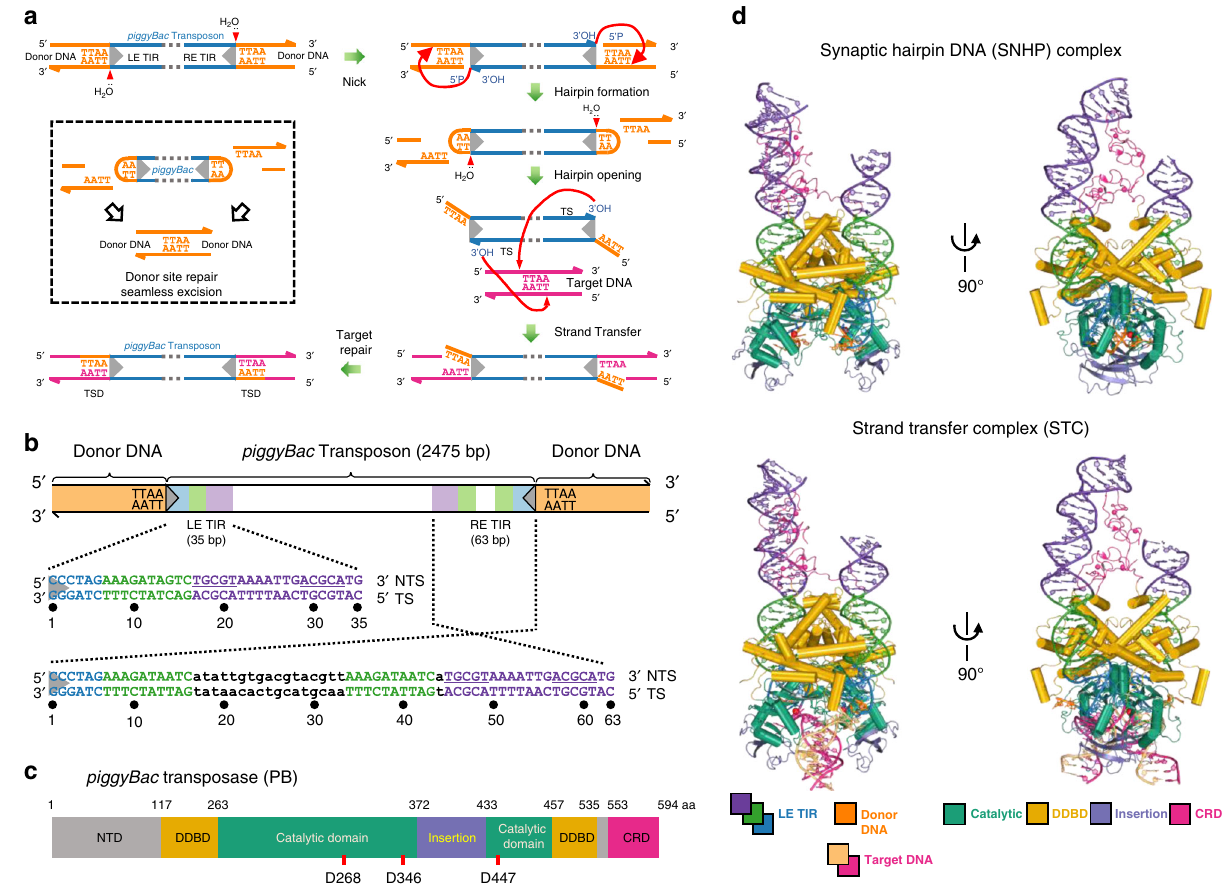
Fig. 1 Overview of piggyBac transposition. a Mechanism of piggyBac ( pB ) transposition. Hydrolysis by the piggyBac transposase (PB) liberates the 3 ′ -OH on the DNA strand that will be integrated. This is followed by transesteri fi cation in which this 3 ′ -OH attacks fl anking DNA four nt from the transposon end forming a DNA hairpin. For subsequent integration, PB opens the hairpin at each end in another hydrolytic step, leaving a four nt TTAA overhang; this is followed by a second transesteri fi cation step that joins each end to target DNA. At the empty donor site (inset), complementary DNA strands allow for seamless repair. LE left end, RE right end, TIR terminal inverted repeat, TSD target site duplication. b Schematic of pB transposon fl anked by TTAA, and sequence and organization of the LE and RE TIRs. NTS non-transferred strand, TS transferred strand. c Domain organization of PB. The catalytic domain contains the conserved DDD motif (in red). NTD N-terminal domain. Dimerization and DNA-binding domain (DDBD). CRD C-terminal cysteine-rich domain. Gray indicates disordered regions in the structure. d Overall structures of the synaptic hairpin DNA (SNHP) complex and strand transfer complex